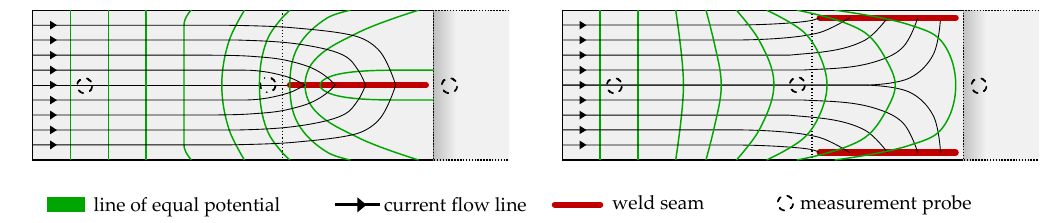
ff ecting voltage